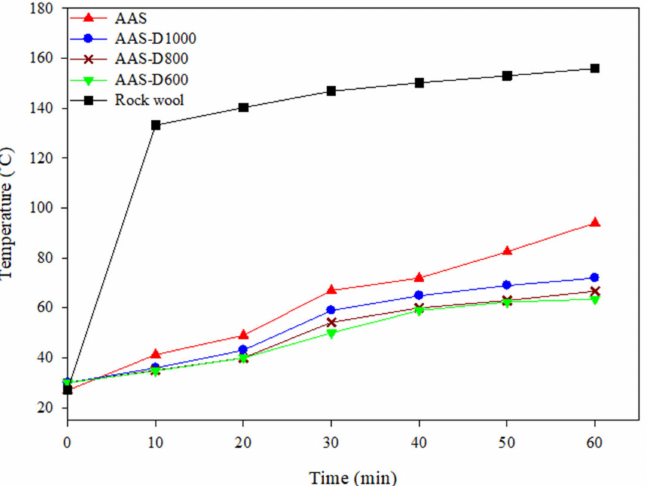
Figure 5. Back panel temperature of alkali-activated porous plates under 800 ◦ C flame (Na 2 O% = 4%,